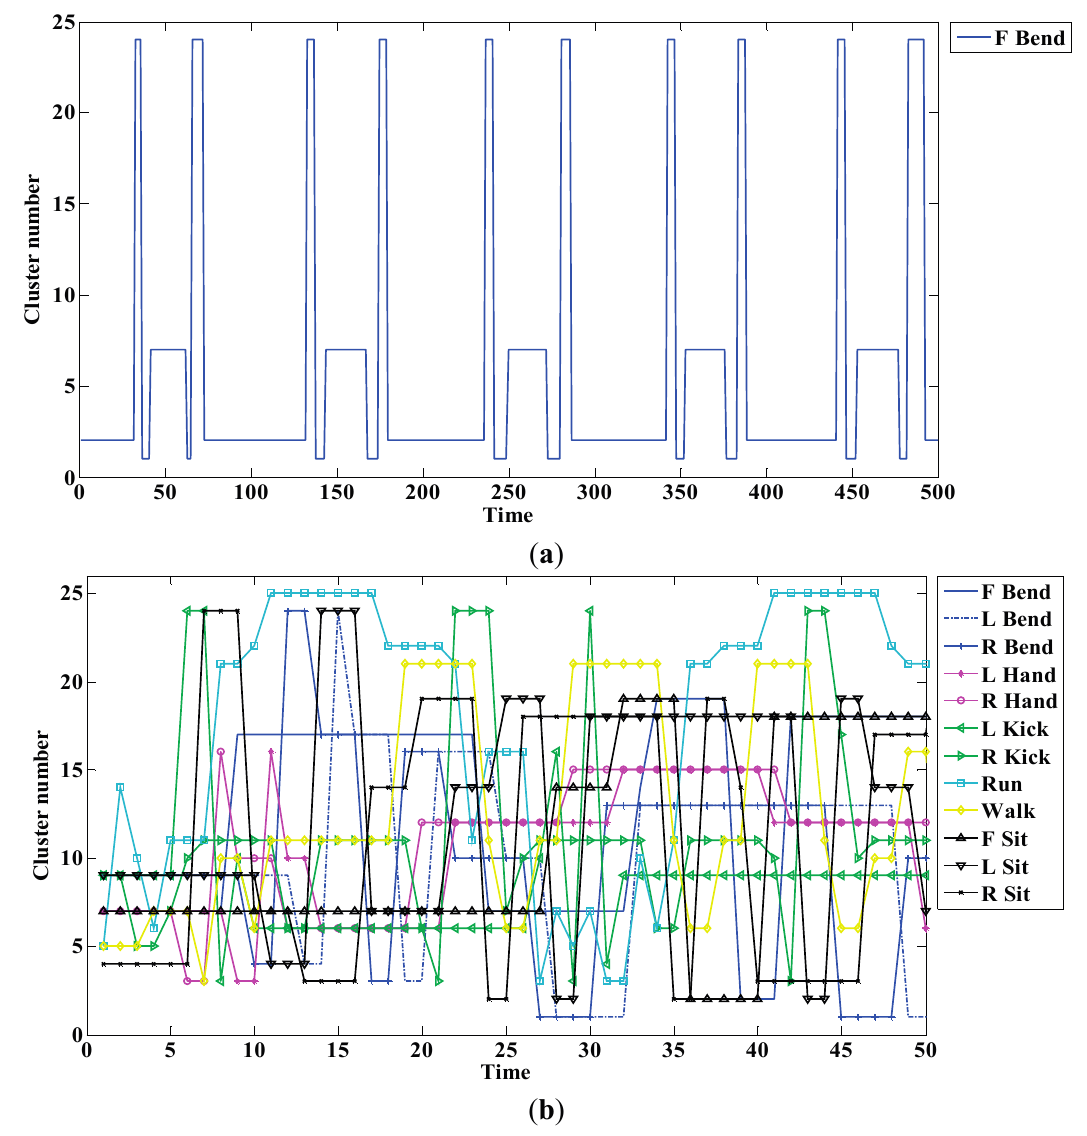
Figure 6. Cluster number for ( a ) a single action; and ( b ) all